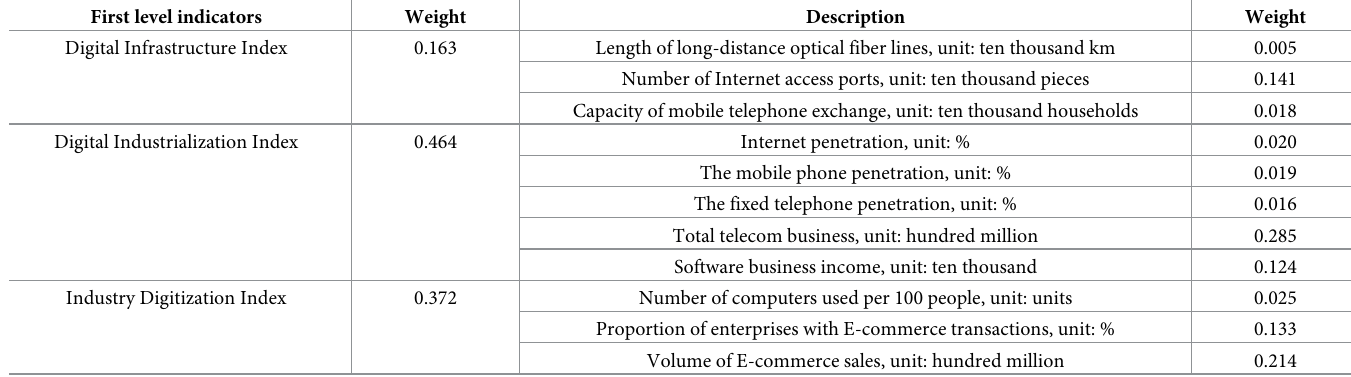
Table 2. Digital economy evaluation index system.